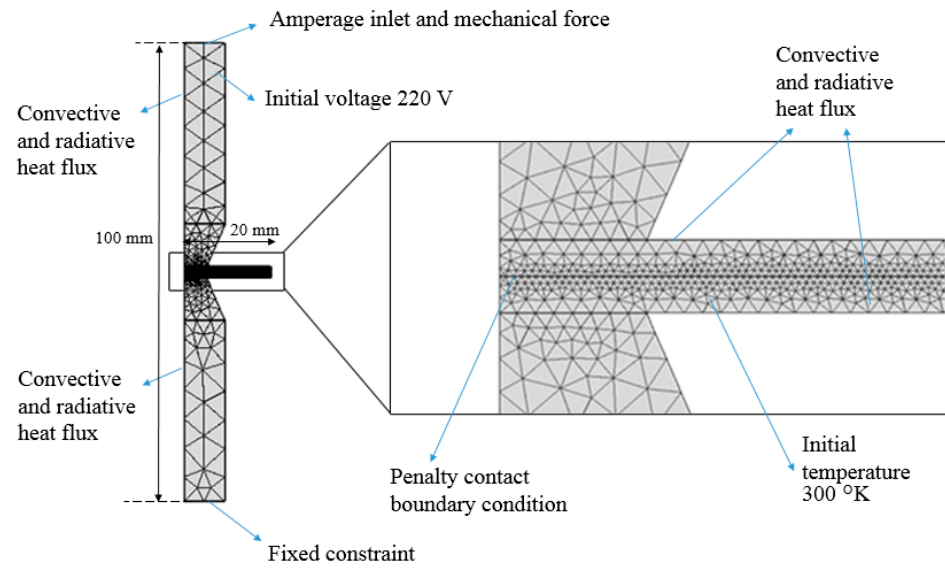
Figure 2. Geometry, boundary conditions, and meshing of resistance spot welding model .